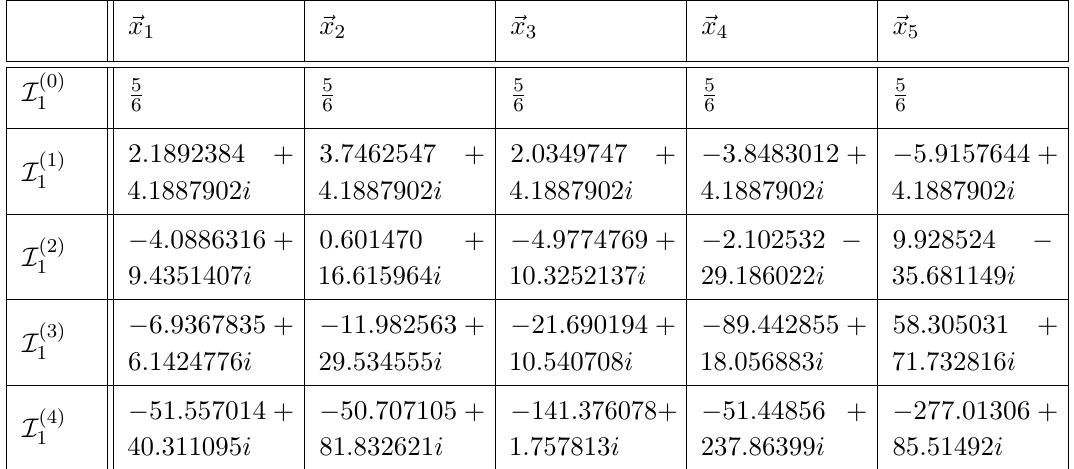
indicates the k -th order 1